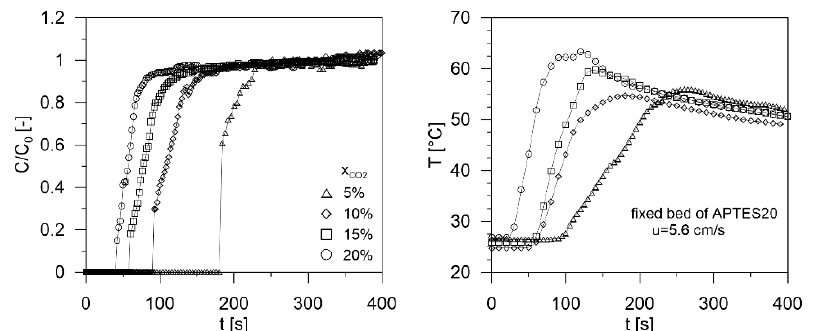
Figure 8. Breakthrough curves at a fixed concentration of CO 2 (12%) for functionalized silica.